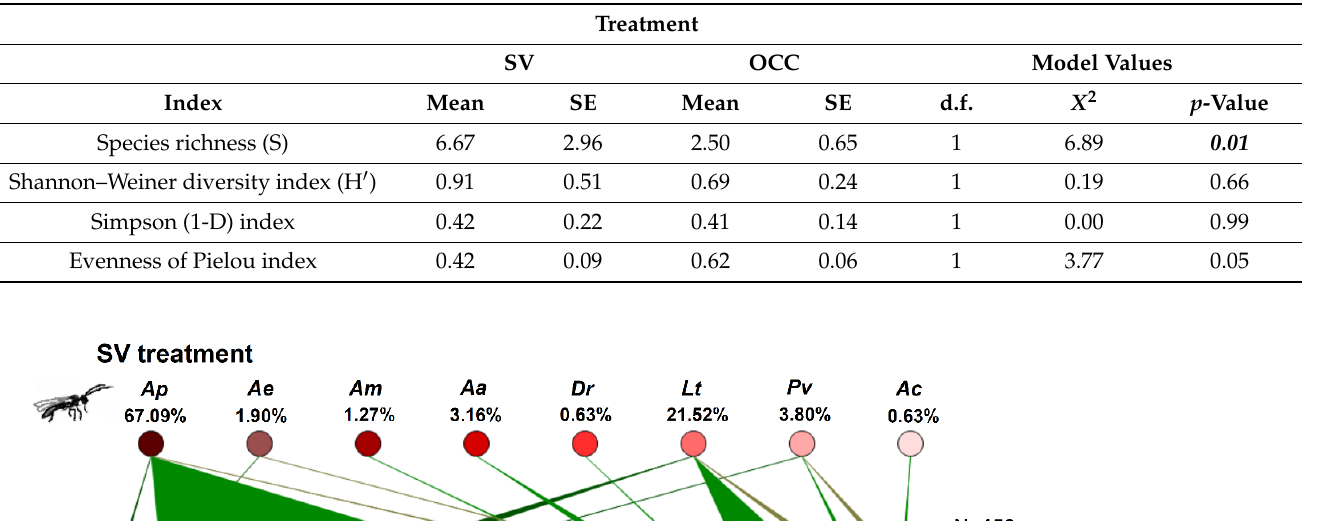
Table 1. Summary of diversity indices between the spontaneous vegetation (SV) and the oat cover crop (OCC) treatments for all parasitoids present. In addition, generalized linear models (GLMs) show statistical differences among treatments for each of the indices evaluated.